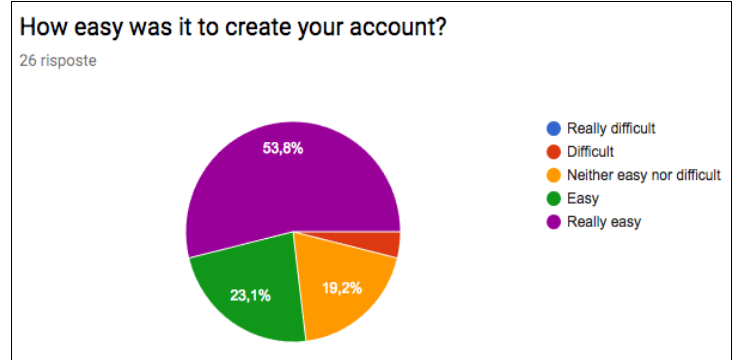
Figure 6. Difficulty of the account creation